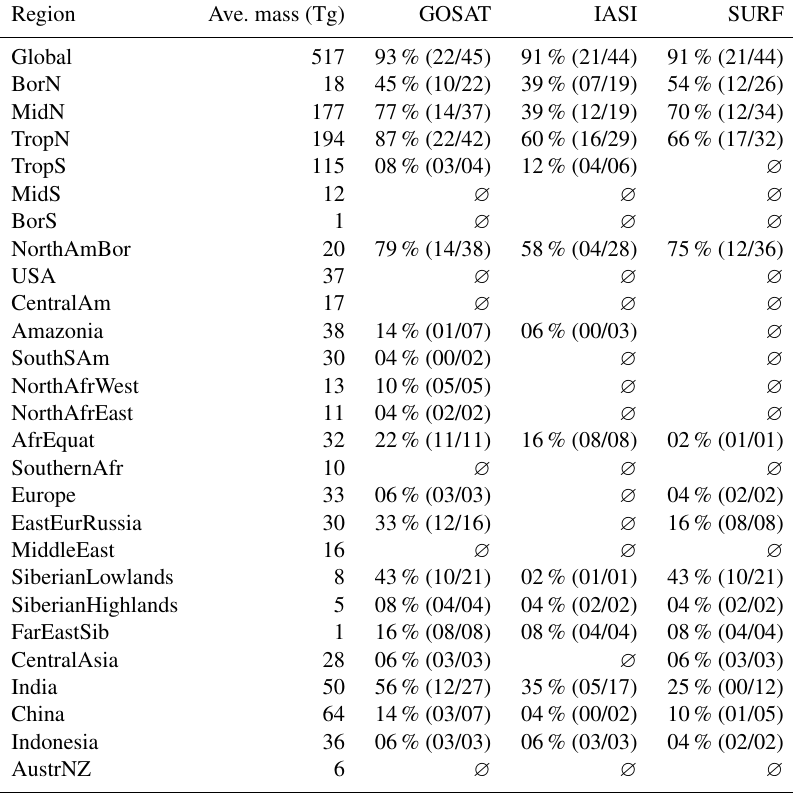
Table 1. Detection of the signal consisting in the anomalies at the seasonal timescale, i.e., quarters of the year (JFM, AMJ, JAS, OND). The signal is the difference between each quarter in the 2000–2011 period (i.e., 48 occurrences) and the 2004–2005 average from REFSURF. The noise is computed at the quarter timescale from each of the three observation systems, GOSAT, IASI and SURF. See Sects. 2.4 and 2.3 for details. In each cell of the table, we show X % ( YY/ZZ ) where X % is the percentage of quarterly anomalies detected (among 48 possible), YY is the number of positive anomalies detected among the ZZ detected anomalies. Column labeled Ave. mass indicates the average emitted mass of CH 4 over 2004–2005 in the